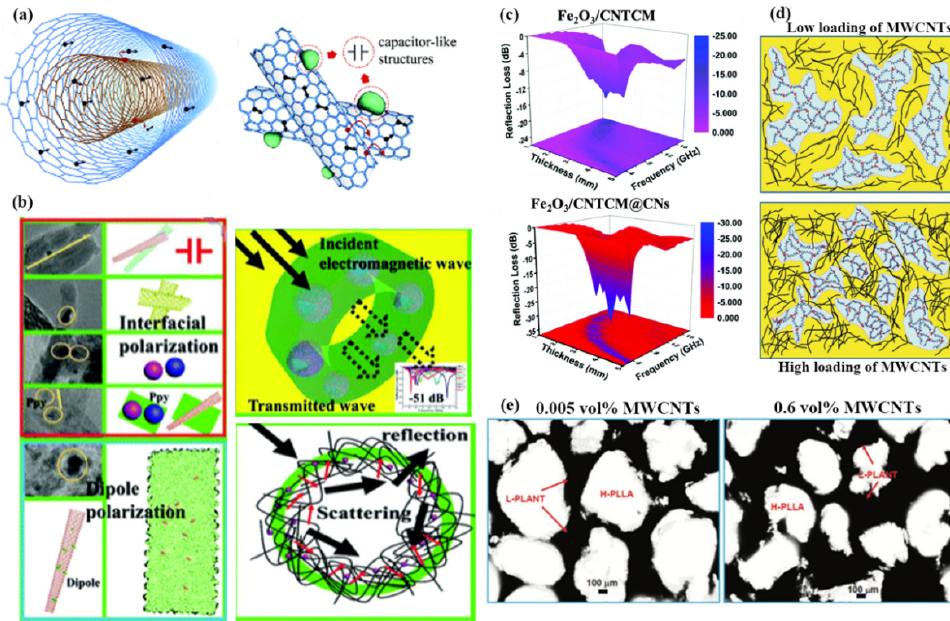
Figure 4. ( a ) Schematic of electron transport in MWCNT and ZnO@CNTs. Reproduced with per- mission from Lu et al. [8], Multi-wall carbon nanotubes decorated with ZnO nanocrystals: mild solution-process synthesis and highly efficient microwave absorption properties at elevated tem- perature; published by Royal Society of Chemistry, 2014. ( b ) Schematic of the microwave loss of the Fe 2 O 3 /CNTCM@CN composites. ( c ) Microwave reflection losses with the 3D map images of Fe 2 O 3 /CNTCM and Fe 2 O 3 /CNTCM@CNs. Reproduced with permission from Yu et al. [69], Im- proved microwave absorption performance of a multi-dimensional Fe 2 O 3 /CNTCM@CN assembly achieved by enhanced dielectric relaxation; published by Elsevier, 2020. ( d ) Schematic illustrations of the MWCNT redistribution in PLLA/PCL/MWCNT (PLLA/PCL 60/40) nanocomposites with low and high loadings of MWCNTs with 20 wt% PDLA in the PLLA phase. Reproduced with permission from Zhang et al. [70], Morphological regulation improved electrical conductivity and electromag- netic interference shielding in poly( L -lactide)/poly( ε -caprolactone)/carbon nanotube nanocompo- sites via constructing stereocomplex crystallites; published by Royal Society of Chemistry, 2017. ( e ) OM images of the S-PLLA/MWCNT composites with MWCNT contents of 0.05 vol% and 0.6 vol%. Reproduced with permission from Zhang et al. [71], Ultralow percolation threshold and enhanced electromagnetic interference shielding in poly(l-lactide)/multi-walled carbon nanotube nanocom- posites with electrically conductive segregated networks; published by Royal Society of Chemistry, 2017.